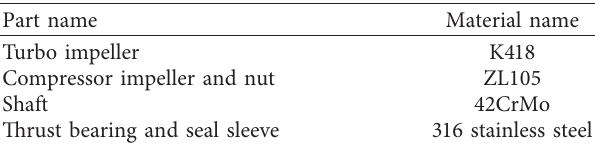
Figure 4: Composition of the rotor-shaft system. Table 3: Material of the main part of the rotor-shaft